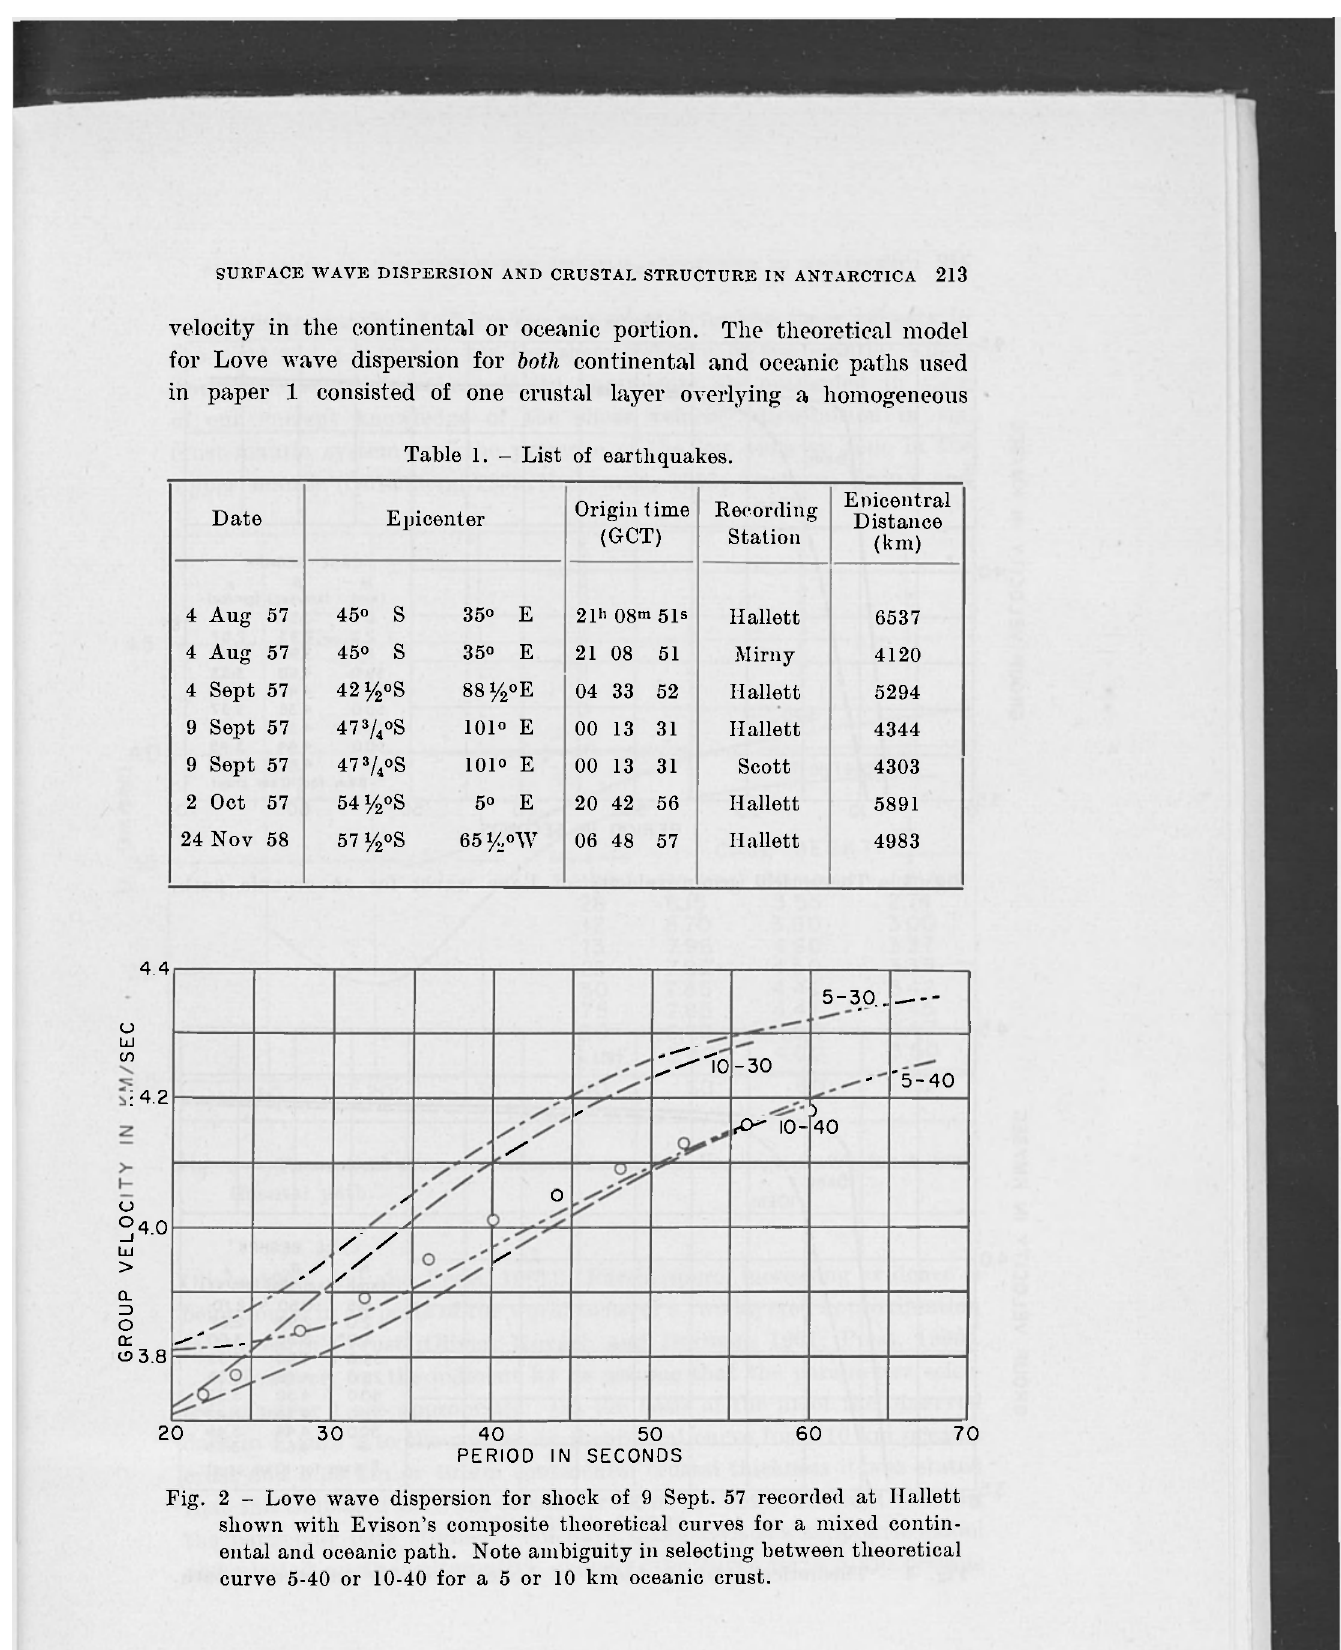
Fig. 2 - Love wave dispersion for shook of 9 Sept. 57 recorded at Ilallett shown with Evison's composite theoretical curves for a mixed contin- ental and oceanic path. Note ambiguity in selecting between theoretical curve 5-40 or 10-40 for a 5 or 10 km oceanic